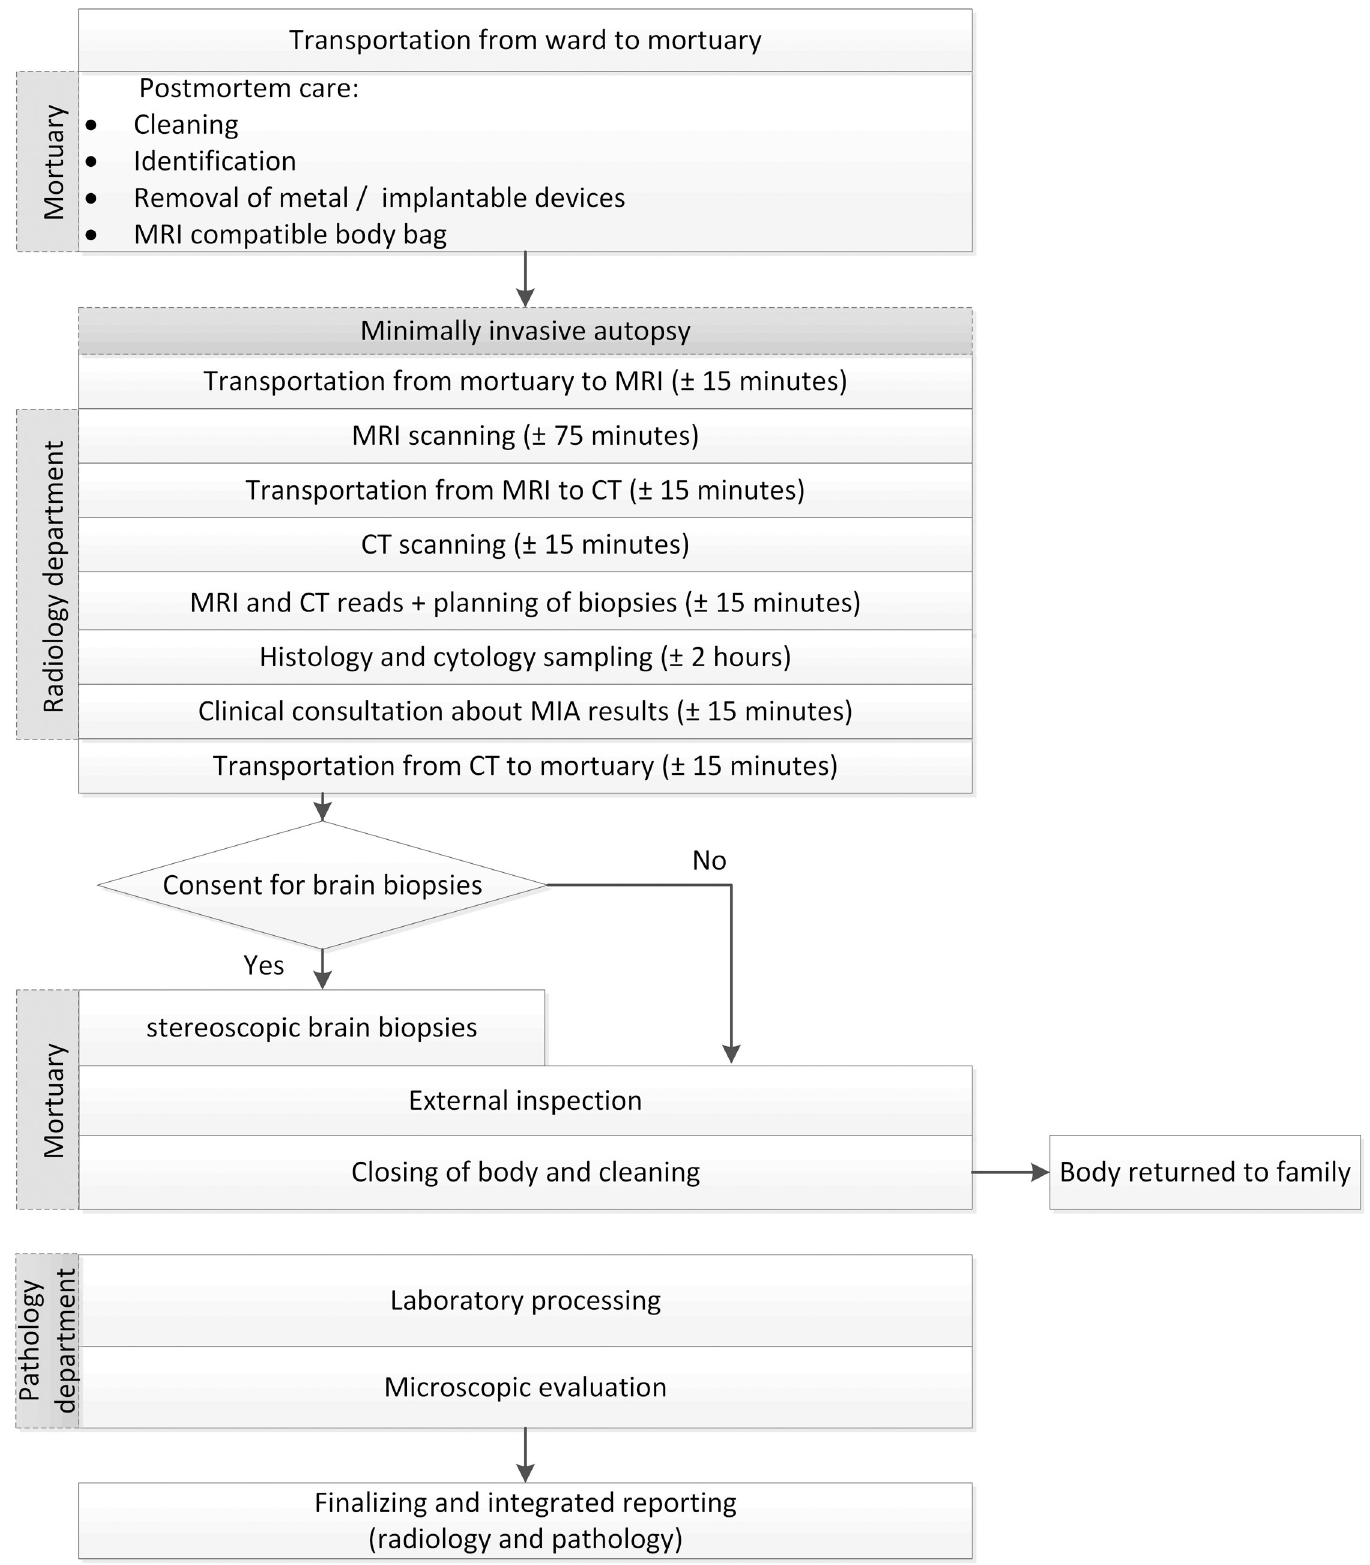
Fig 1. Logistical flow-chart of minimally invasive